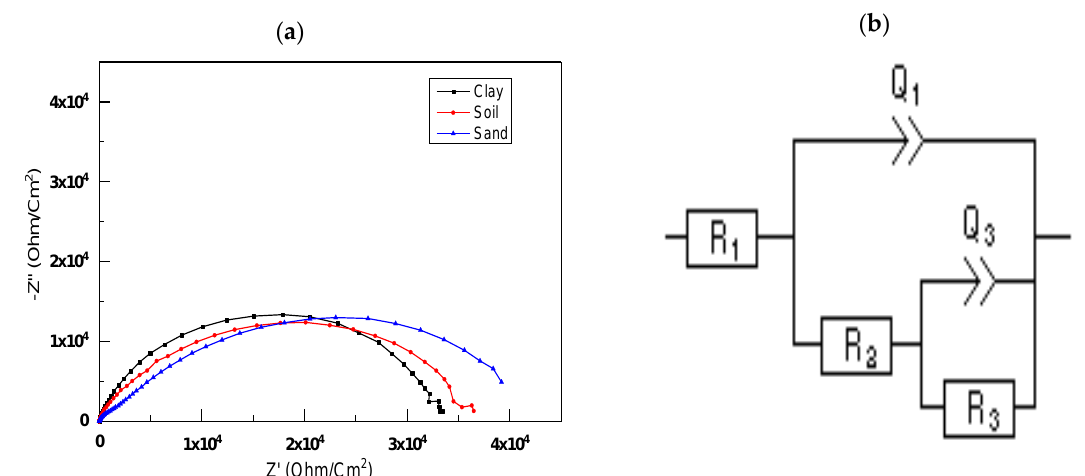
Figure 5. ( a ) Nyquist plots of the coated steel in the different soil extract, ( b ) Equivalent electric circuit. Table 4. Impedance parameters and corrosion resistance of the coated steel. R 1